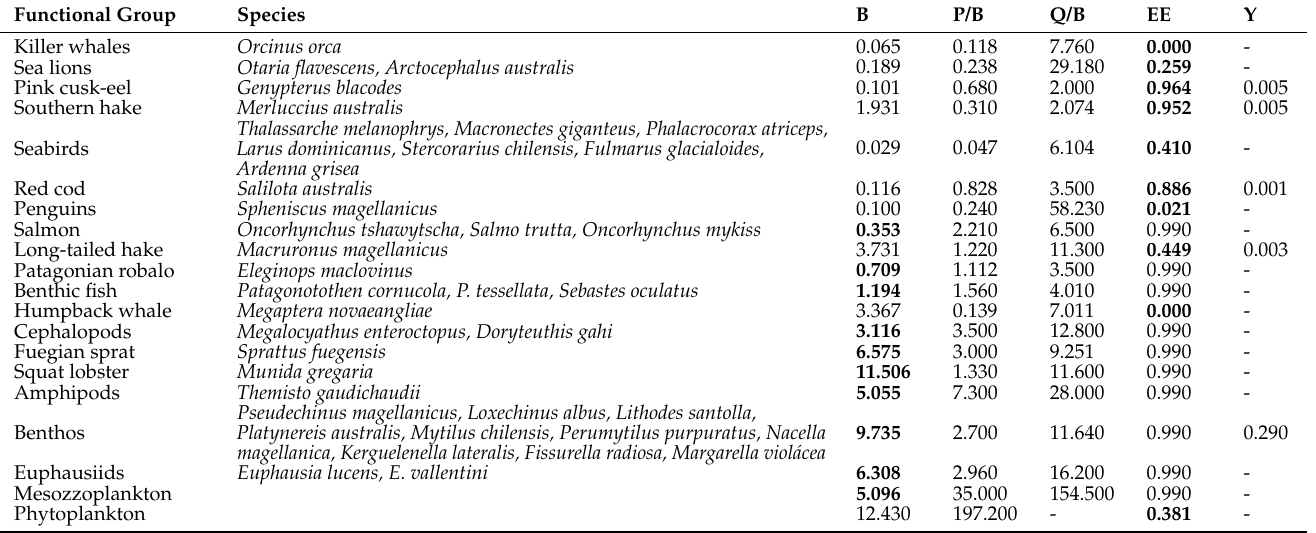
Table 1. Basic input parameters and biomasses of the functional groups of the model in the Francisco Coloane Marine Area, Magellan Strait. B: biomass (t km 2 ), P/B: production/biomass (year − 1 ), Q/B: consumption/biomass (year − 1 ), EE: ecotrophic efficiency, Y: fishing landing (t km 2 year − 1 ). Values estimated by the model are in